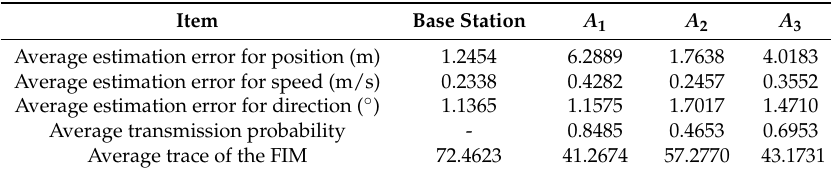
Table 7. The average estimate errors, the average transmission probability, and the average trace of the FIM in Scenario 3. Item Base Station A 1 A 2 Average estimation error for position